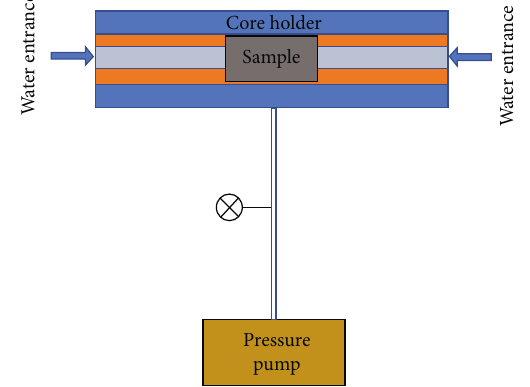
Figure 5: The schematic of the apparatus that was used by Bin et al. [76] and Wang et al. [25] to conduct imbibition tests with con fi ning pressure.